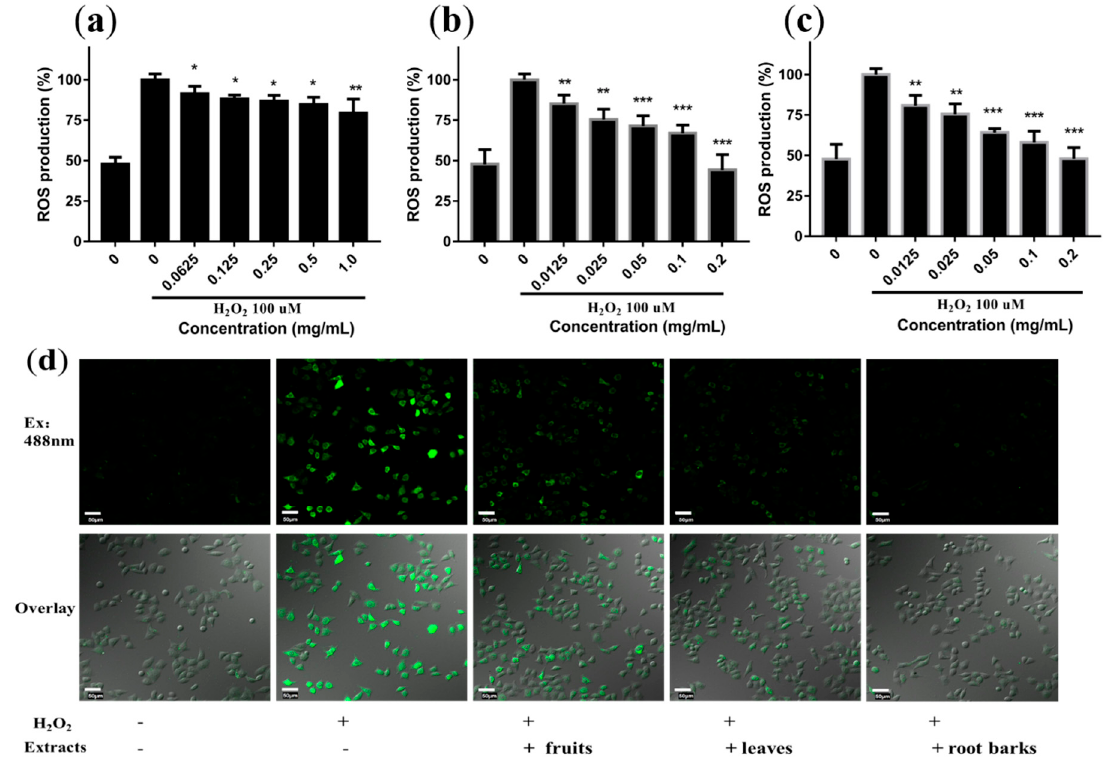
Figure 4. Protection effect of different concentrations of extracts from fruits ( a ), leaves ( b ) and root barks ( c ) on 100 µM H 2 O 2 -induced intracellular ROS production in L02 cells. Results were expressed as means ± SD, n = 3. * p < 0.05, ** p < 0.01, *** p < 0.001, vs. the H 2 O 2 treated group. ( d ) Confocal imaging of intracellular ROS levels after H 2 O 2 stimulation in the presence of extracts of fruits (1 mg/mL), leaves and root barks (0.2 mg/mL) (scale bar, 50 µm).